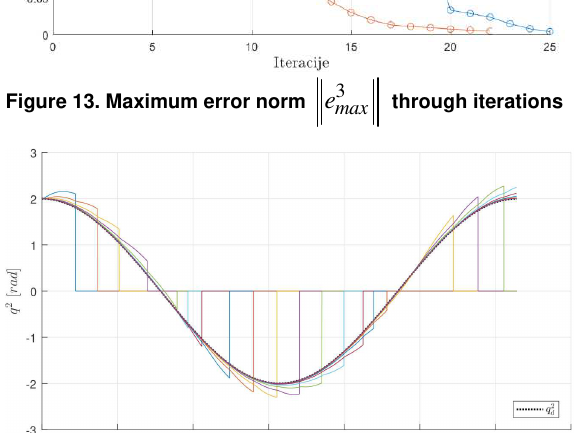
Figure 16. Maximum error norm